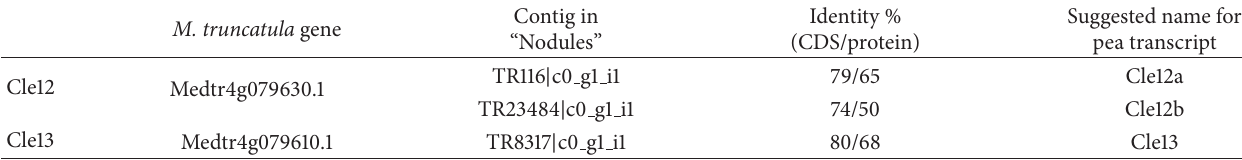
Table 3: Pea transcripts homologous to Medicago truncatula transcripts encoding Cle12 and Cle13